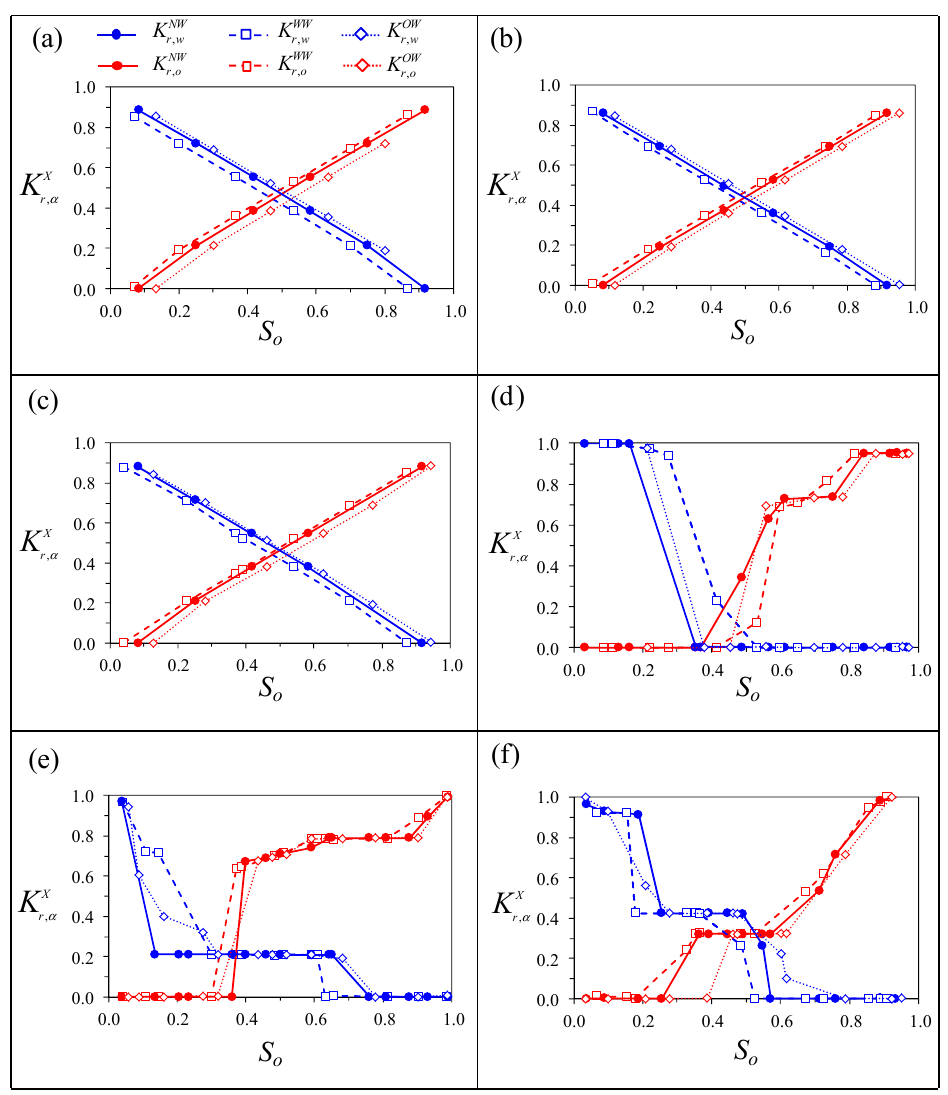
X K α ) in ( a ) HDa, ( b ) HDb, ( c ) HDc, ( d ) E1, ( e ) E4, and ( f ) E8 , r